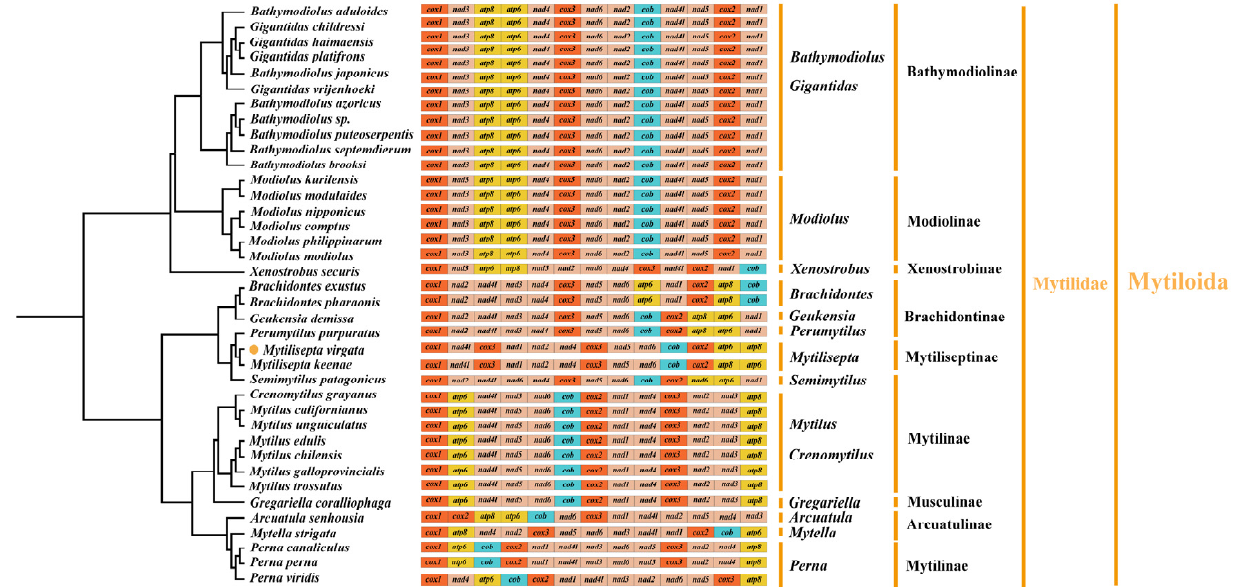
Figure 5. Linearized representation of the mitochondrial gene arrangement in Mytilidae bivalves (see Figure 7 for detailed relationships among Mytilidae species). Gene segments are not drawn to scale. The gene arrangement of all genes is transcribed from left to right. The orange dot indicates the specie of this study.